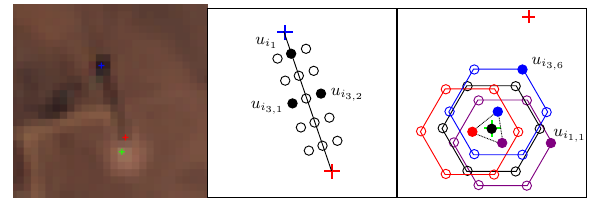
Figure 3. Left, a wind turbine view from a Sentinel-2 image, with its hub shadow (blue cross), pylone foot (red cross) and hub (green cross). Middle, zoomed in, the sampling along the pylone shadow where n s = 5 . Right, zoomed in, the sampling around the hub where n h = 4